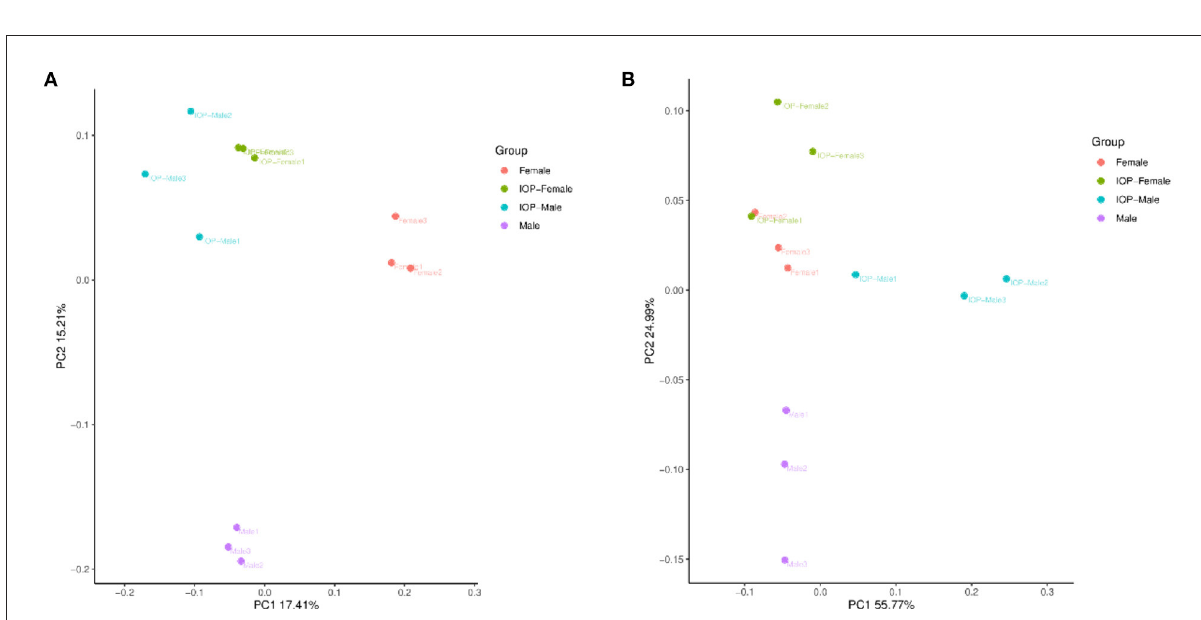
FIGURE4 Beta diversity of samples based on Adonis test. (A) PCoA plots based on unweighted unifrac distances for all SD rats. (B) PCoA plots based on weighted unifrac distances for all SD rats.